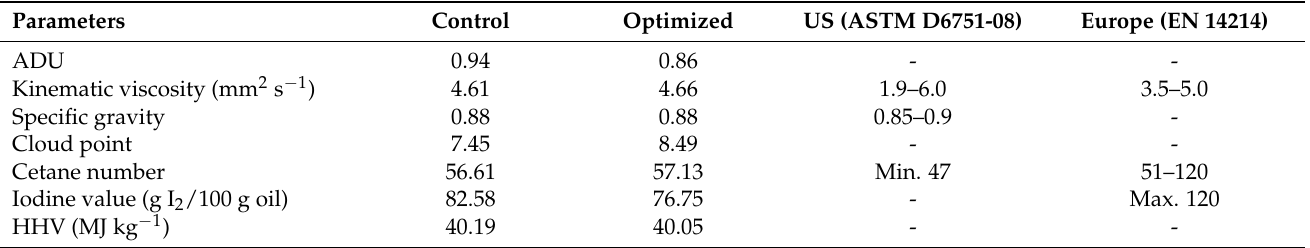
Table 6. The main estimated biodiesel characteristics of the Chlorella sp. grown under optimized conditions in comparison with the control and calculated based on fatty acid